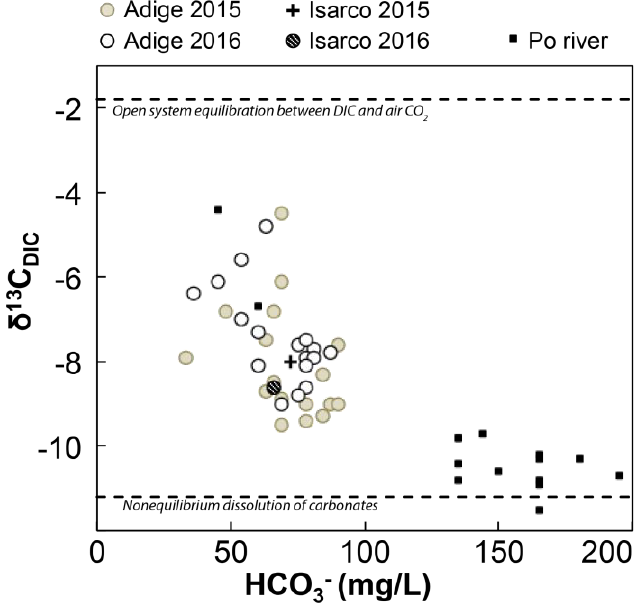
Figure 4. HCO 3 − and δ 13 C DIC measured in Adige river water compared with Po river water from Marchina et al. [16], and the isotopic compositions expected for open system equilibrium between DIC and atmospheric CO 2 and that expected for non-equilibrium dissolution of carbonates [53].